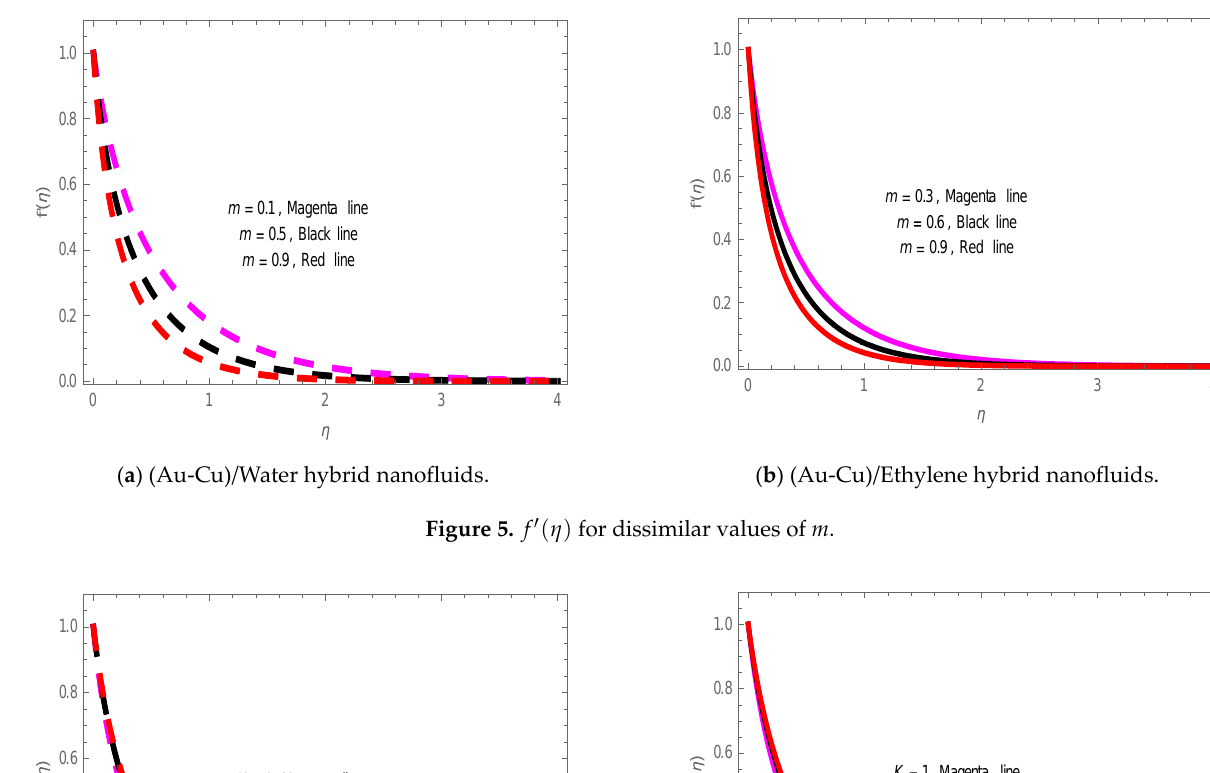
Figure 4. 𝑓 ′ (𝜂) for dissimilar values of M.